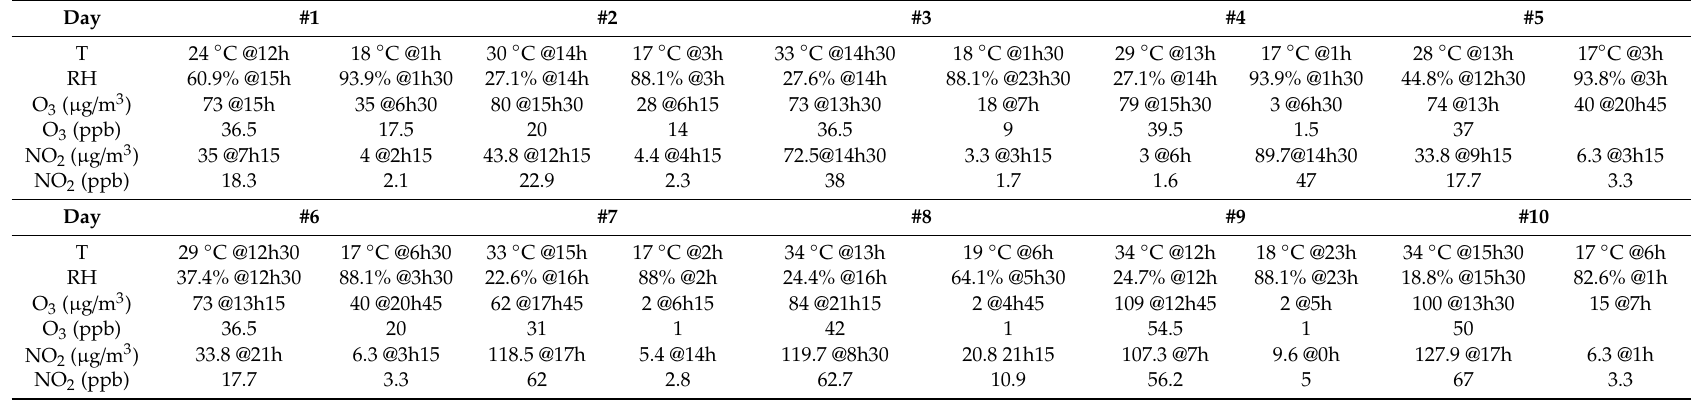
Table 3. Maximum and minimum values during the campaign, near the roundabout “Rotunda de Entrecampos”, school break period, weekends (shadowed).